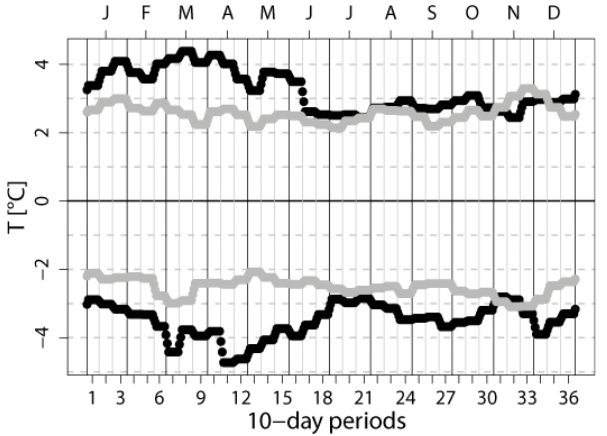
Figure 2. Milan grid point. Scale parameters estimates for the cal- endar year: σ TX + , σ TX in black; σ TN + , σ TN in grey; σ TX and σ TN are − − − − reported with opposite sign (negative